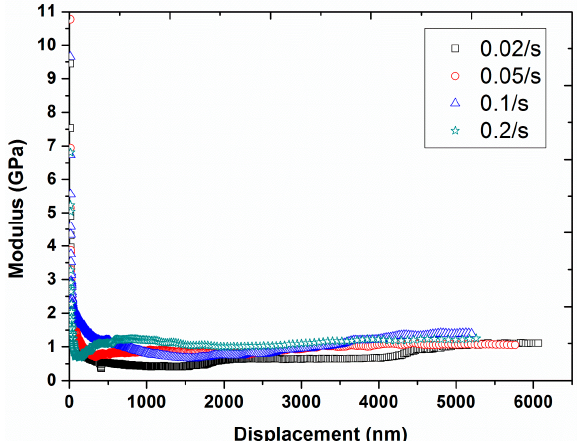
Figure 12. Modulus as a function of displacement for the four different strain rates (0.02, 0.05, 0.1, and 0.2 s − 1 ) at a frequency of 45 Hz and vibration amplitude of 2 nm.